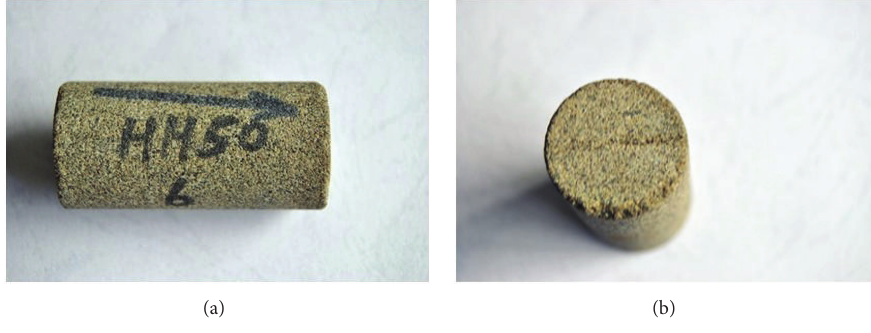
Figure 1: Photos of the sample